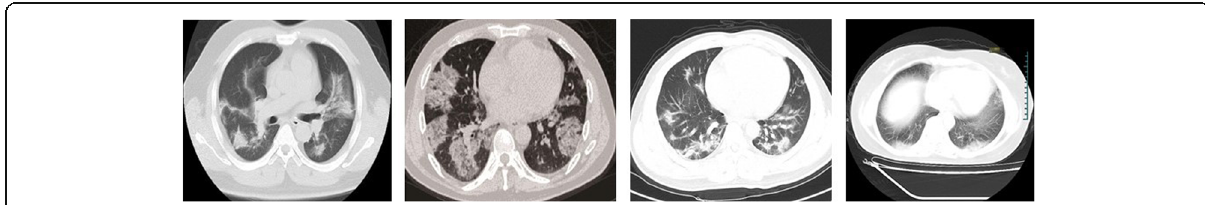
Fig. 5 Sample COVID-19 CT images from the COVID-CT